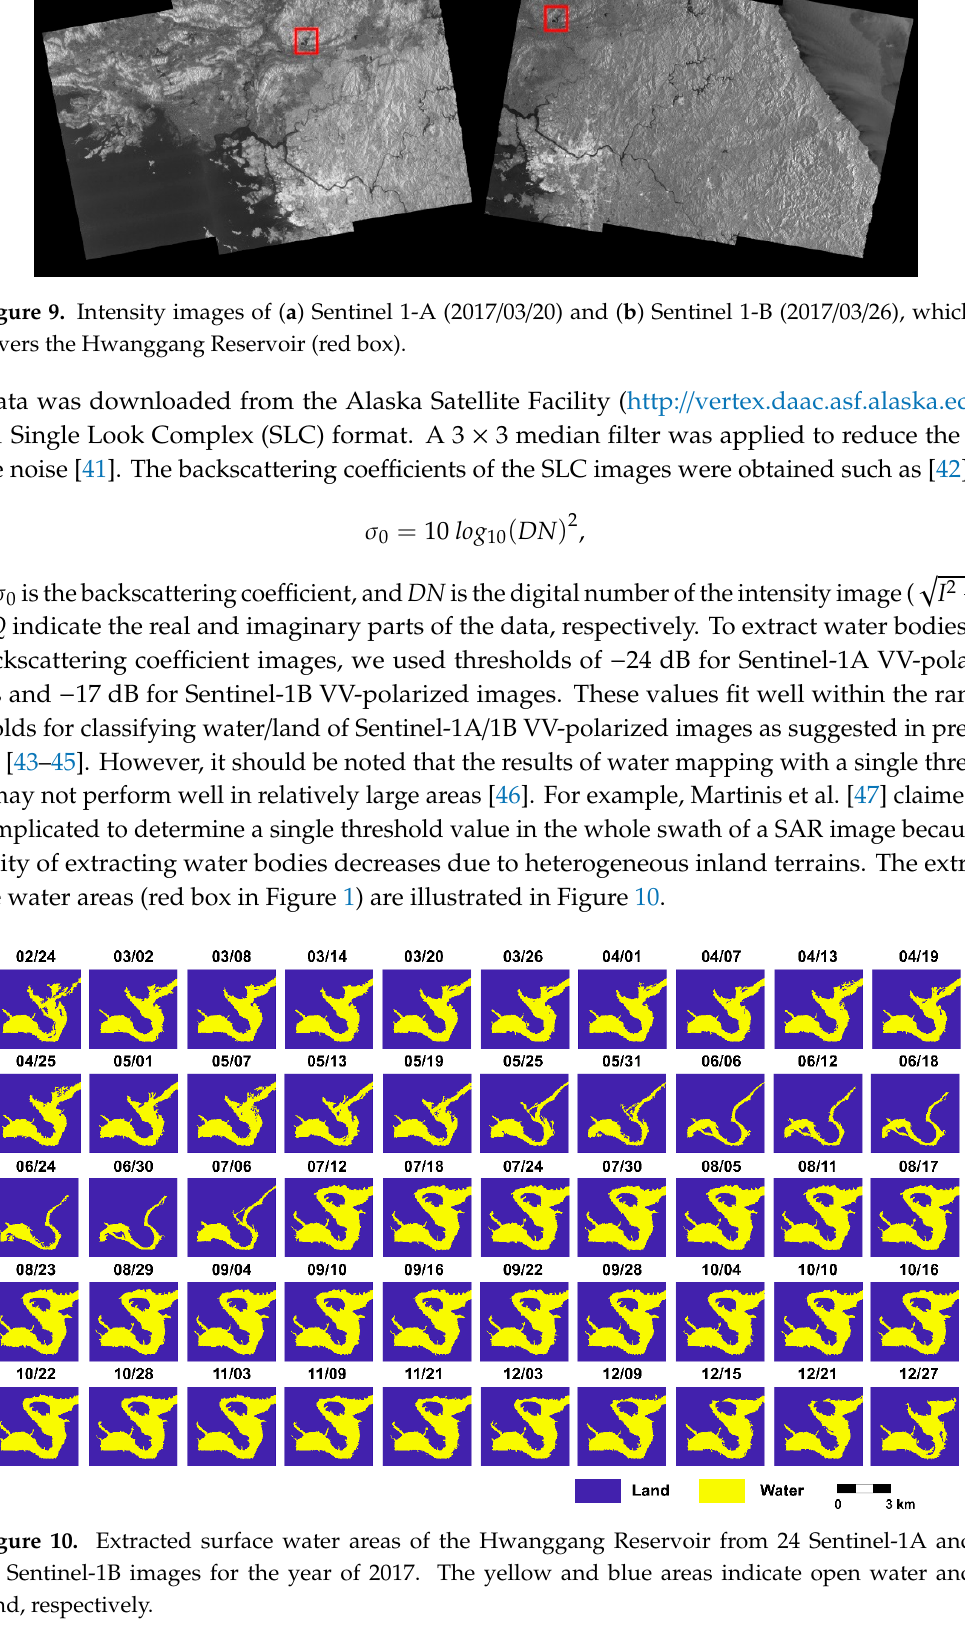
Figure 10. Extracted surface water areas of the Hwanggang Reservoir from 24 Sentinel-1A and 26 Sentinel-1B images for the year of 2017. The yellow and blue areas indicate open water and land, respectively.